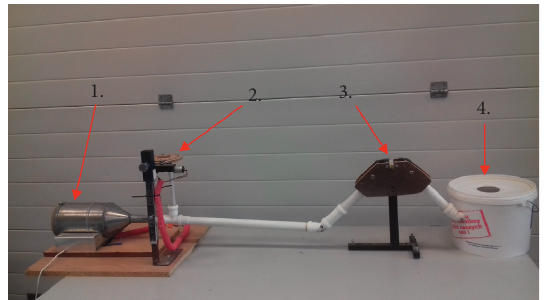
Figure 1: Mechanical design of experimental rig (1—blower, 2—seeds feeding, 3—piezoelectric film foil, 4—tank).